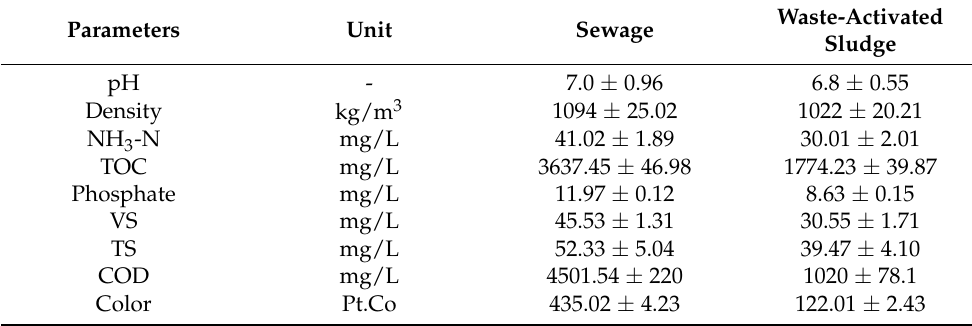
Table 5. Physico-chemical properties of the sewage sludge and waste activated